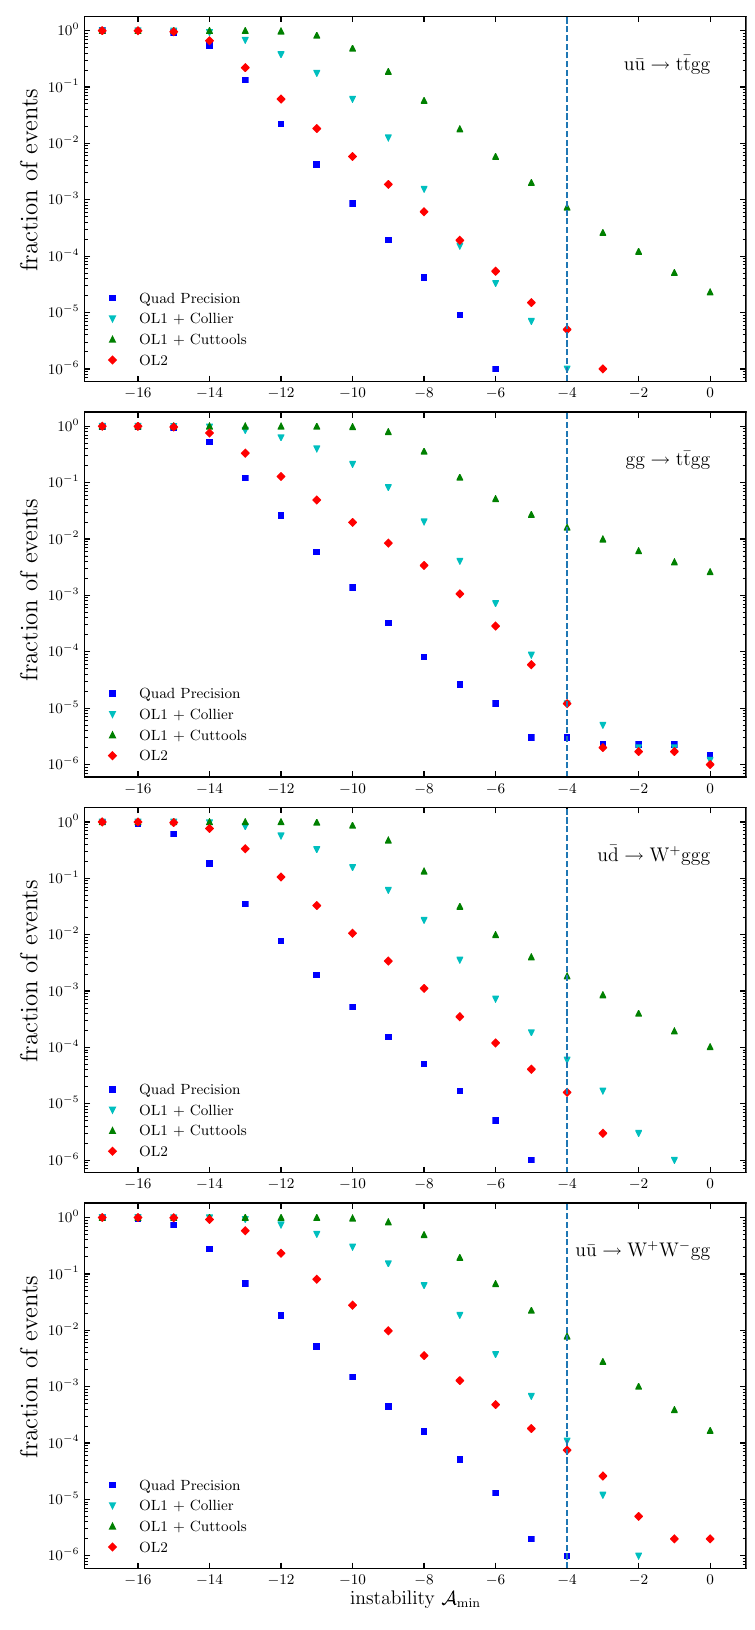
Fig. 17 Stability distributions for 2 → 4 processes defined as in Fig.